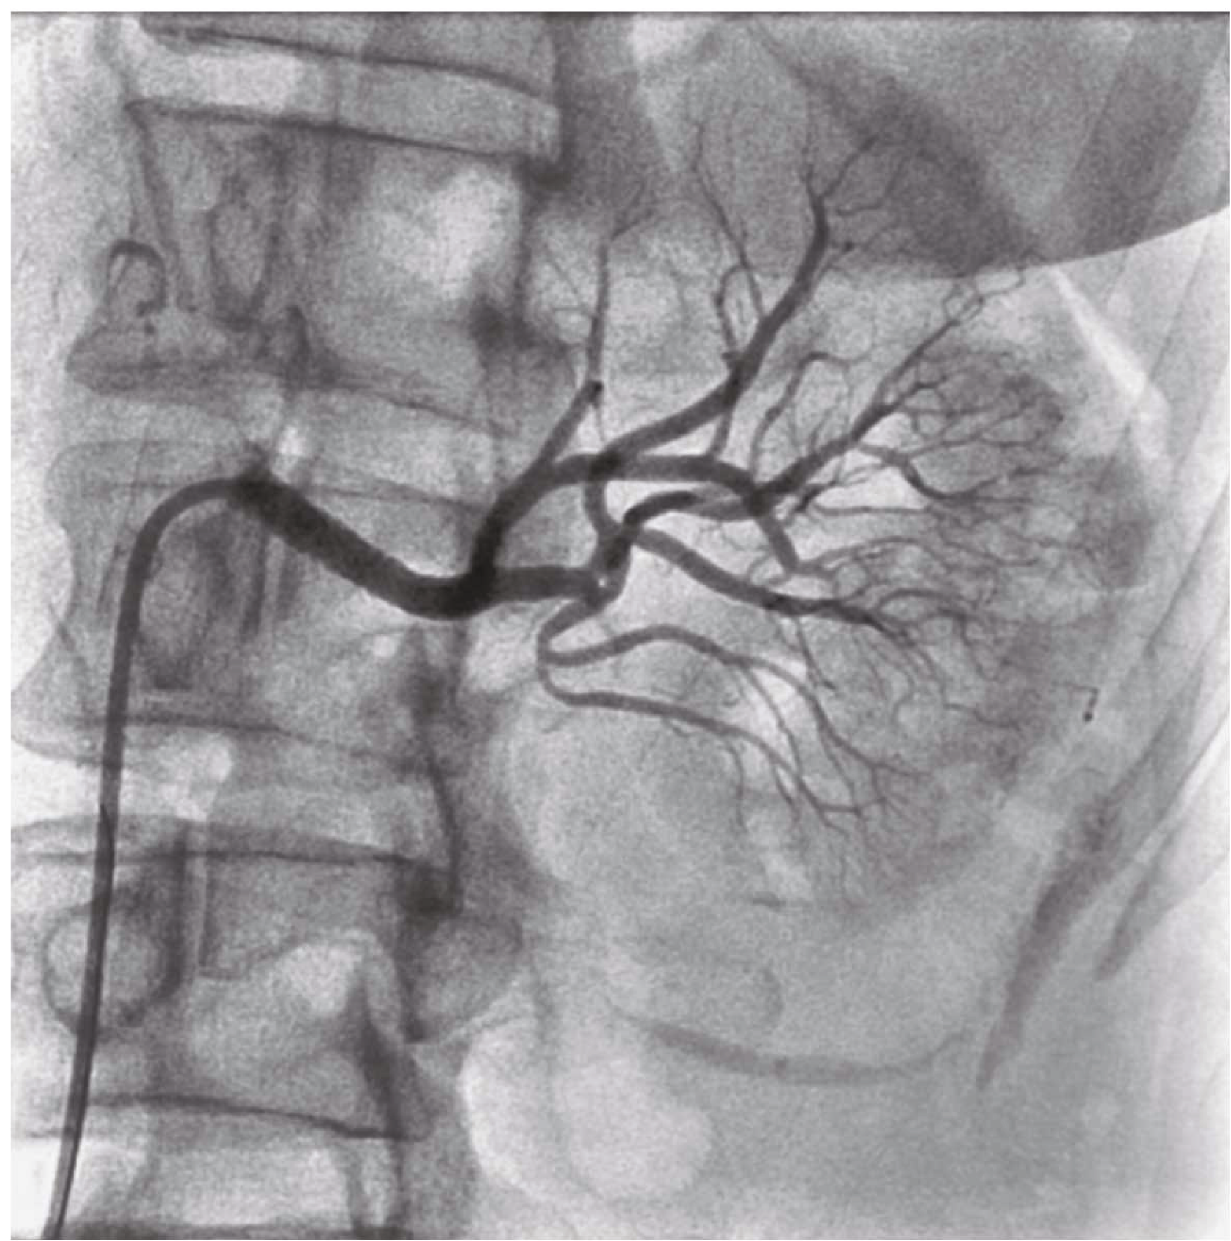
Figure 12: Postrestenting of the renal artery now shows excellent left kidney blush and patent lobular, arcuate and distal kidney vessels with less spasm, and no embolic cut o ff s, compared to Figure